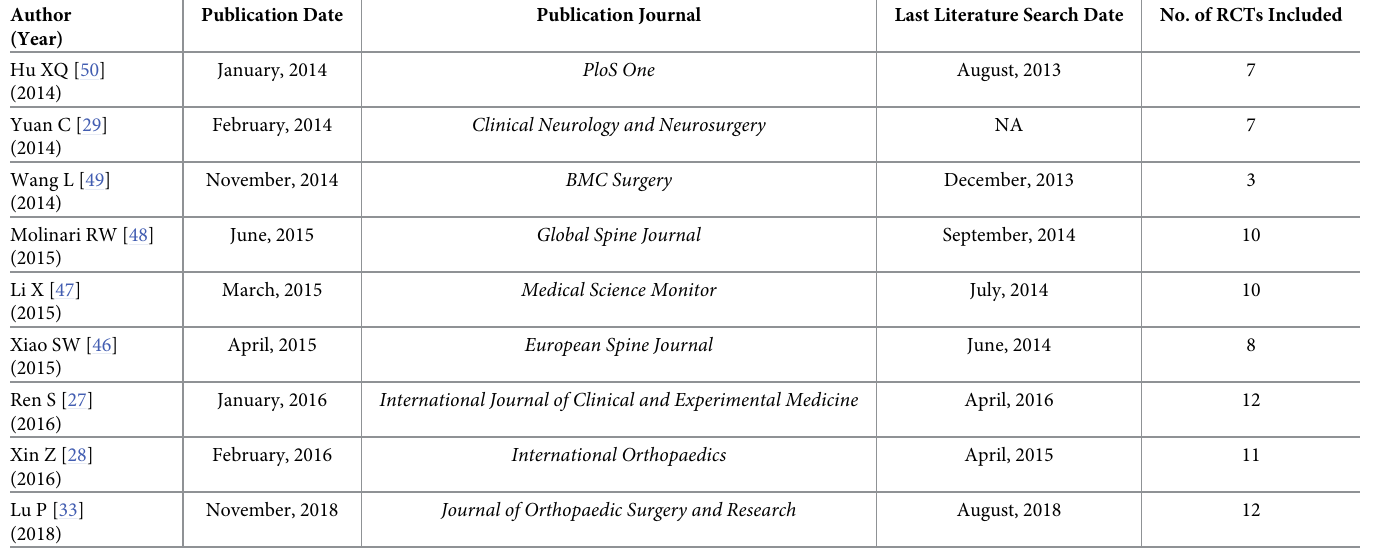
Table 1. Characteristics of each included study.